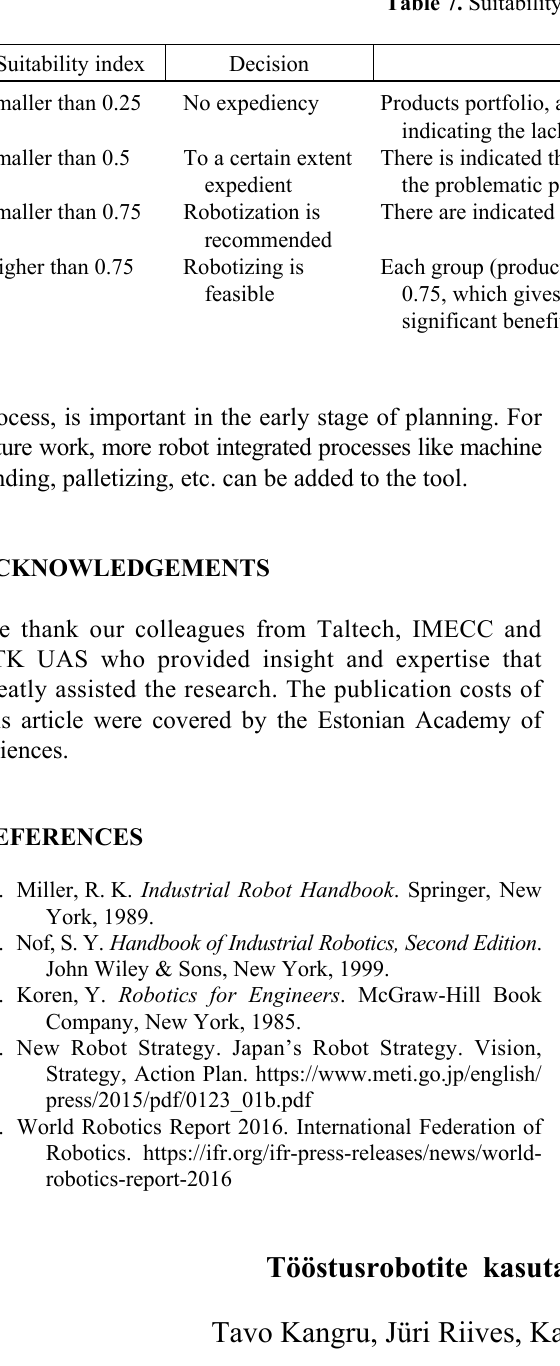
Table 7. Suitability decision